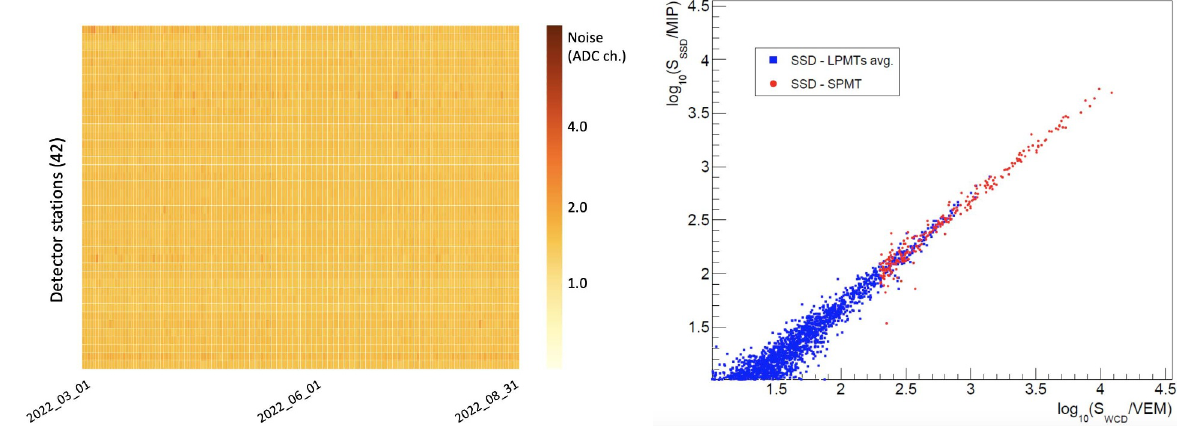
Figure 4. Left: RMS(baseline, high gain channel) of large PMTs as a function of time for a sub-sample of upgraded stations running without interruption. Right: Correlation between SSD and WCD signals. For the WCD, the large PMTs are used up to the saturation (blue dots); the measurements are extended further by the small PMT (red